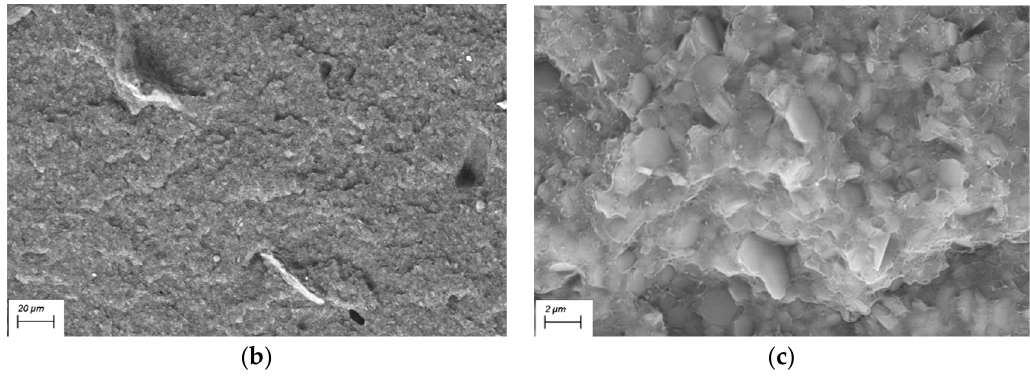
Figure 6. SEM image of ( a ) PEALIFR4031 1000×; ( b ) PEAL60MH 1000×; ( c ) PEAL60MH 10000×.